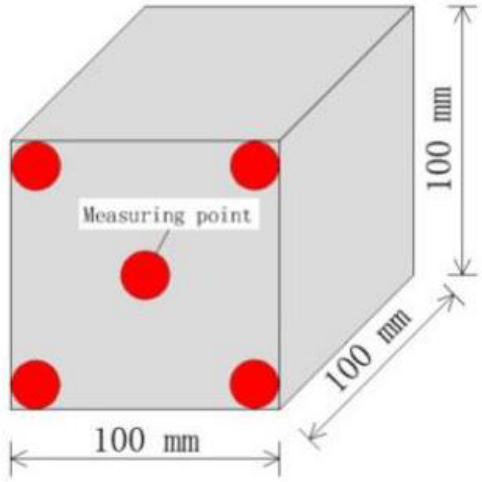
Figure 4. Measuring point positions of the detector.